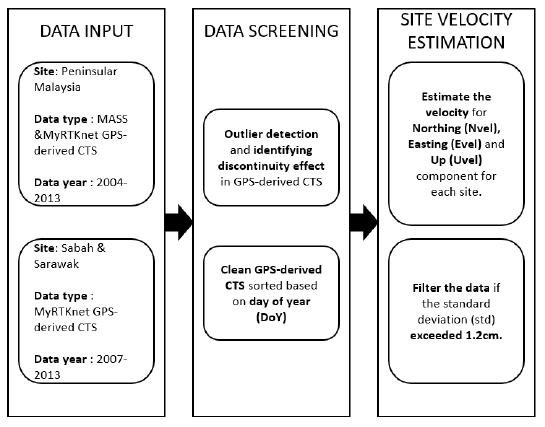
Figure 2. Phase 1: Site velocity estimation